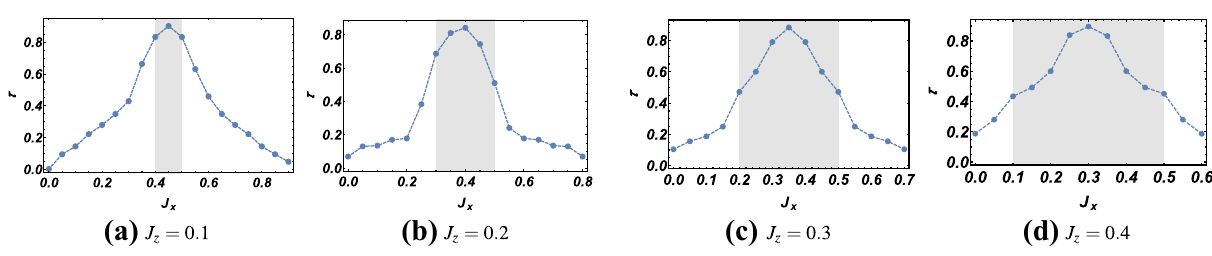
Figure 6. Residual entanglement τ as a function of coupling interaction J x with different J z : ( a ) 0.1, ( b ) 0.2, ( c ) 0.3, ( d ) 0.4 for a N = 4 × 4 × 2